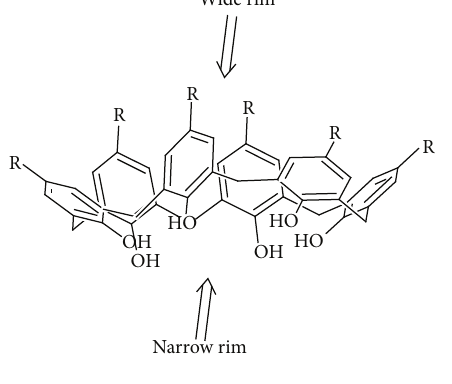
F 1: Illustration of the structure of calixarenes.